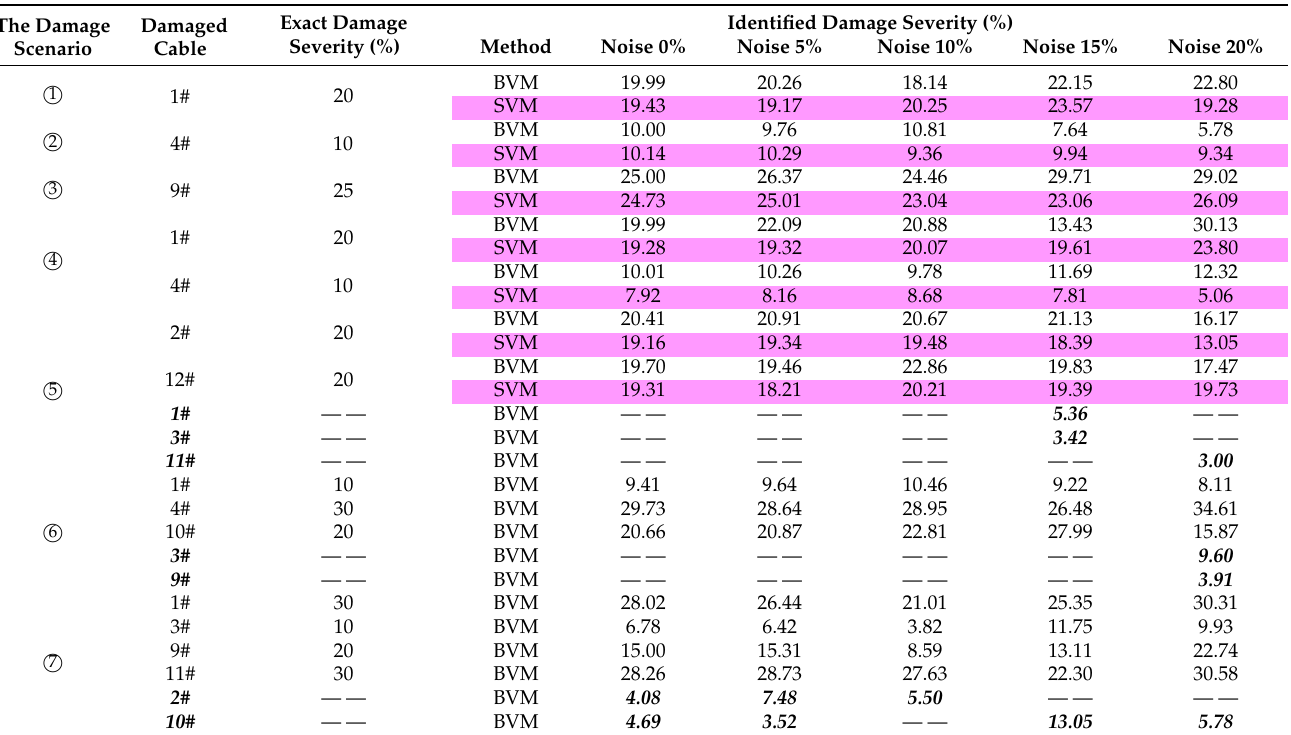
Table 5. The damage severity identification results using the BVM method and the SVM method [18].